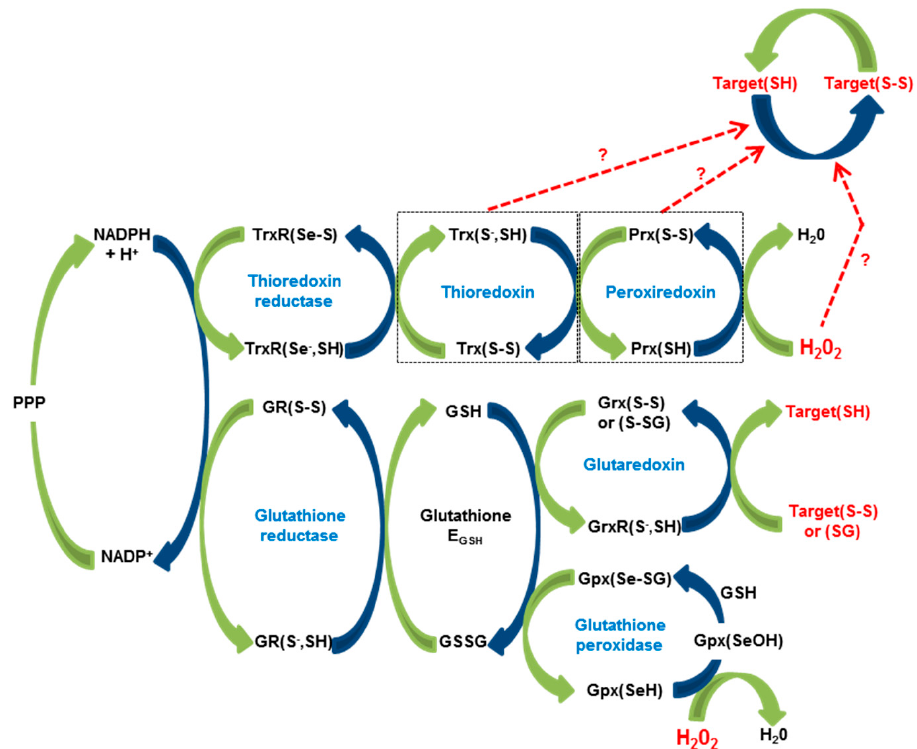
Figure 1. The redox machinery. Interconnection of redox couples from H 2 O 2 to thiol targets are represented. H 2 O 2 is a by-product of oxidative reactions. Major sources include mitochondrial respiratory chain and NOXs for review [18]. PPP: Pentose Phosphate Pathway.